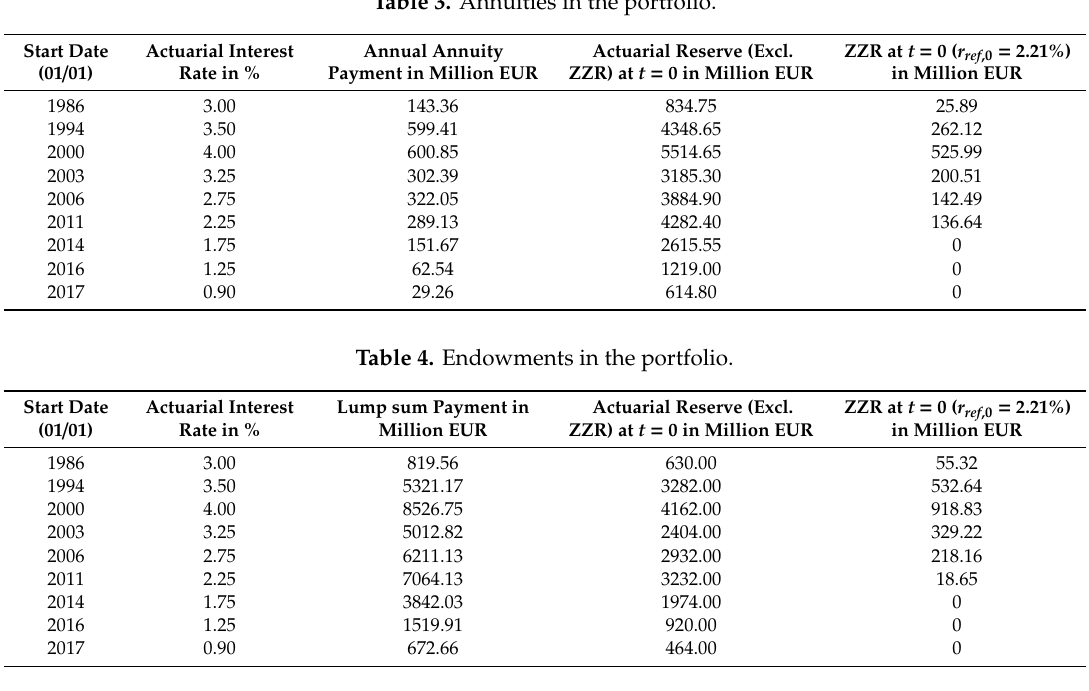
Table 3. Annuities in the portfolio.